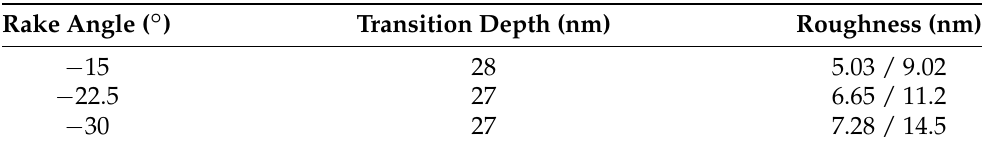
Figure 9. Absolute deviation ( | Z ( x ) | ) of the surface coordinates during the grooving at ( a ) − 15 ◦ , ( b ) − 22.5 ◦ and ( c ) − 30 ◦ rake angles. The deviation is evaluated by subtracting the deformed coordinates from the undeformed coordinate along the grooving direction. The dashed line separates the ductile and the brittle regime. Table 2. Transition depth and roughness values ( Ra ) in ductile and brittle regions as obtained from the grooving simulations for different negative rake angles. The roughness values in the two regimes are separated by a